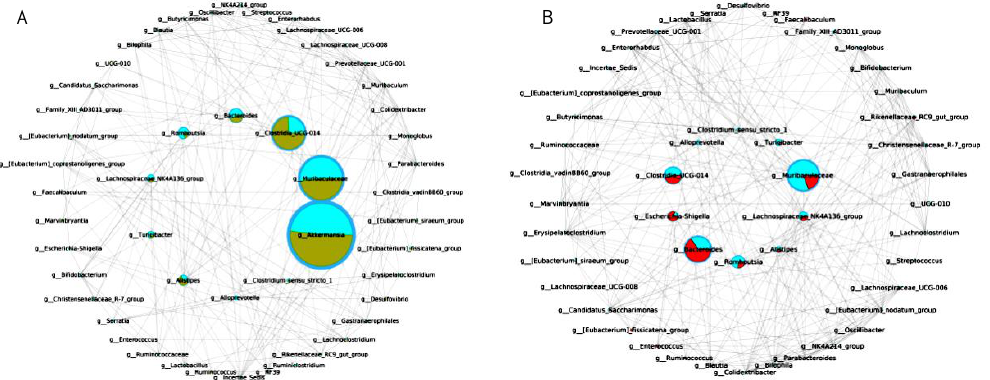
Figure 10. Correlation network analysis of microbial genus levels between B. breve H4-2 and the control ( A ). Correlation network analysis of microbial genus levels between B. breve H4-2 and DSS group ( B ).